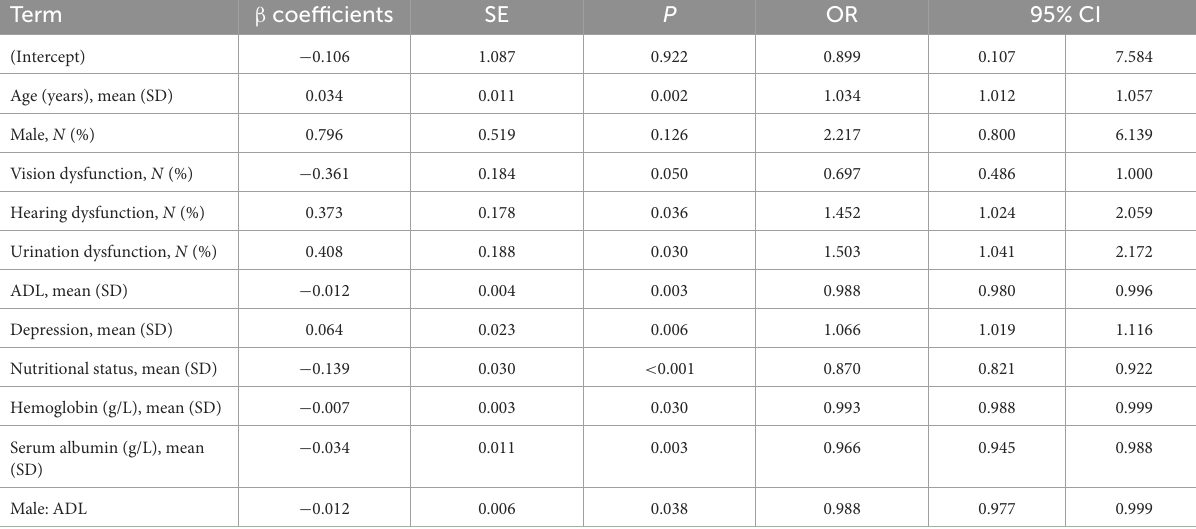
TABLE 2 Final multivariable analysis for frailty risk within 30 days of admission in derivation cohort.